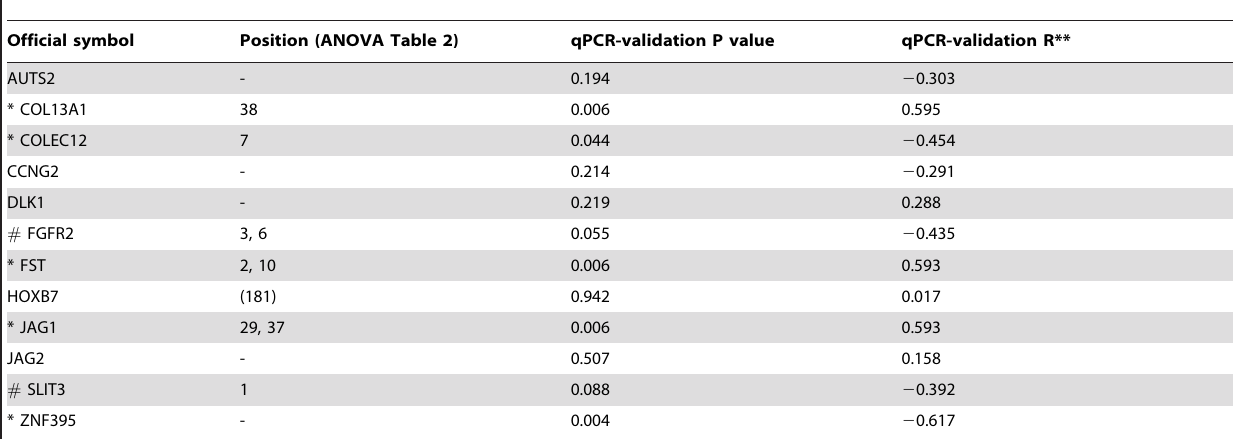
Table 4. Gene expression validated with qPCR in 20